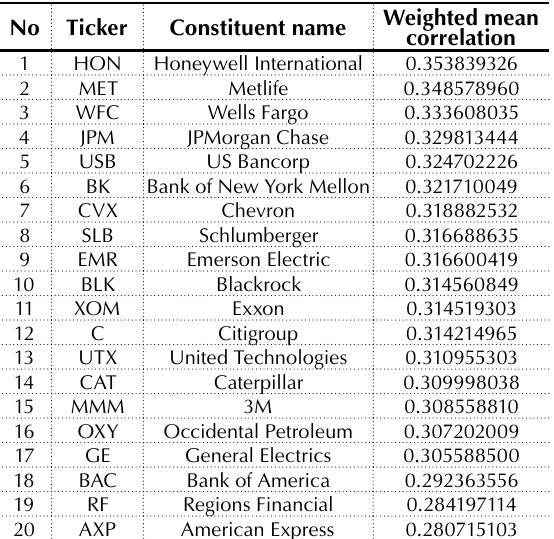
Table 1. Ranking of stocks